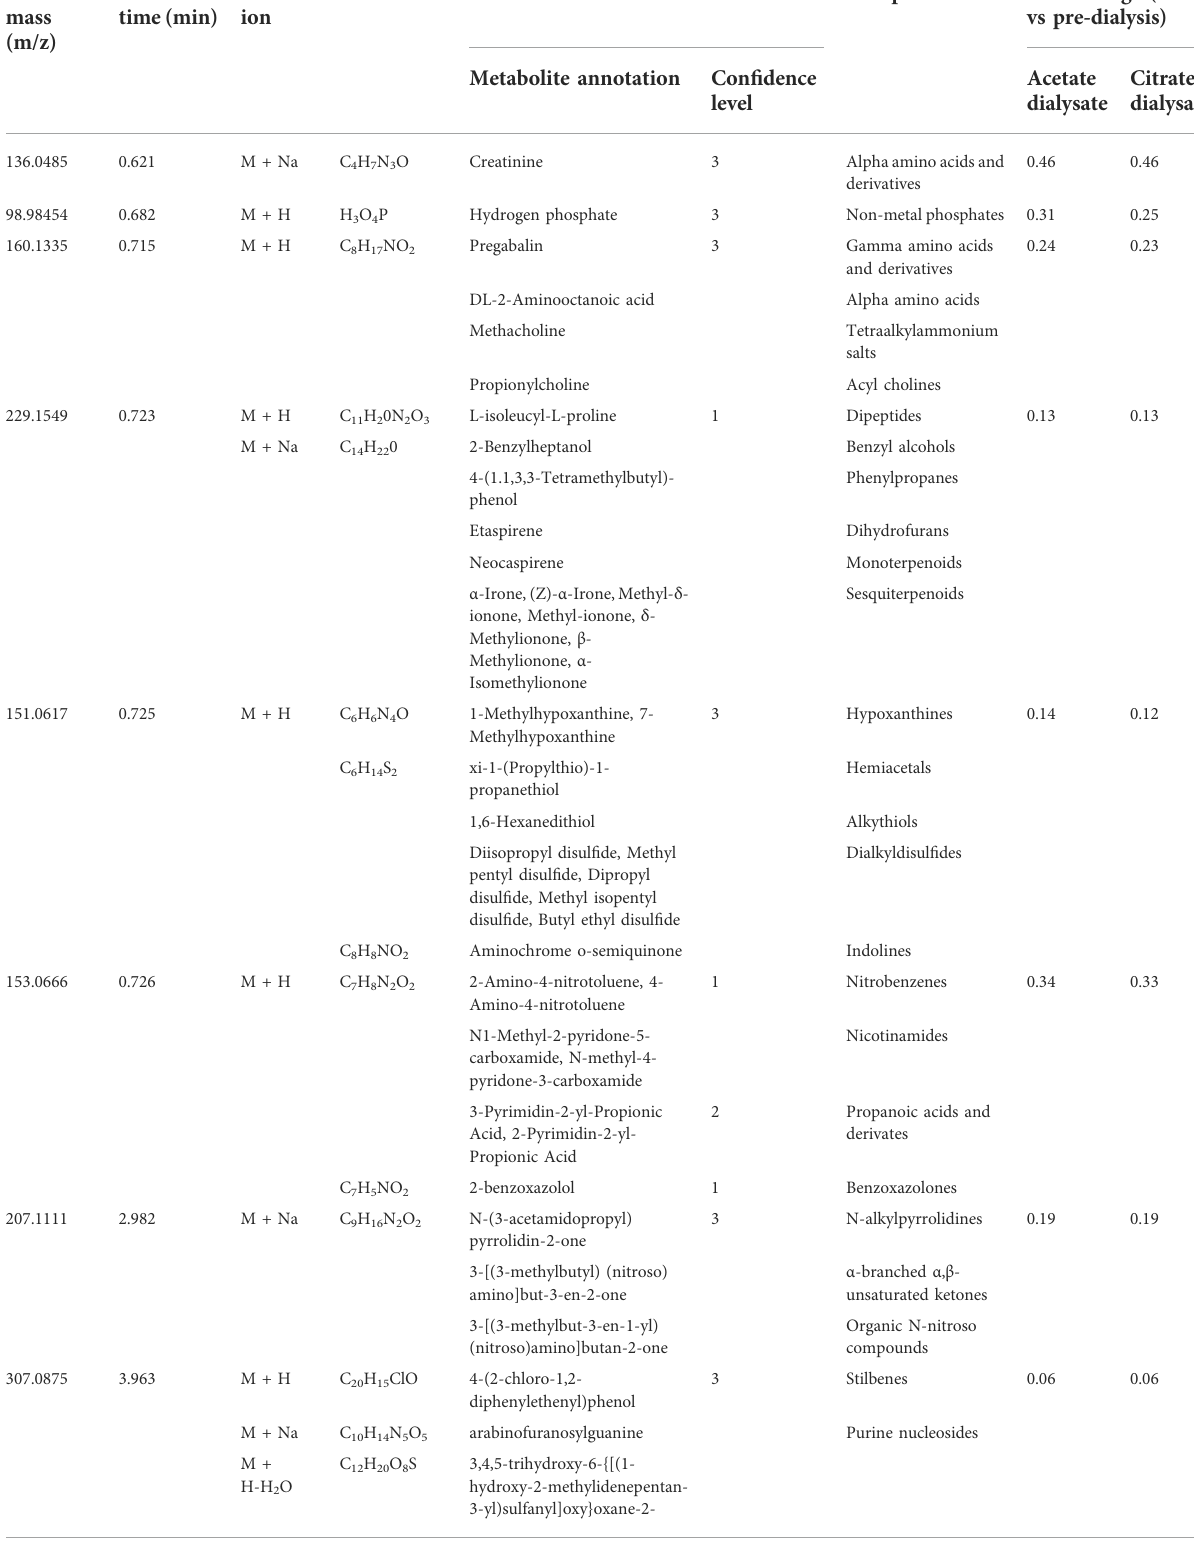
TABLE 3 Identi fi cation of the most discriminant metabolomic variables between pre- and post-dialysis with both dialysates. Accurate